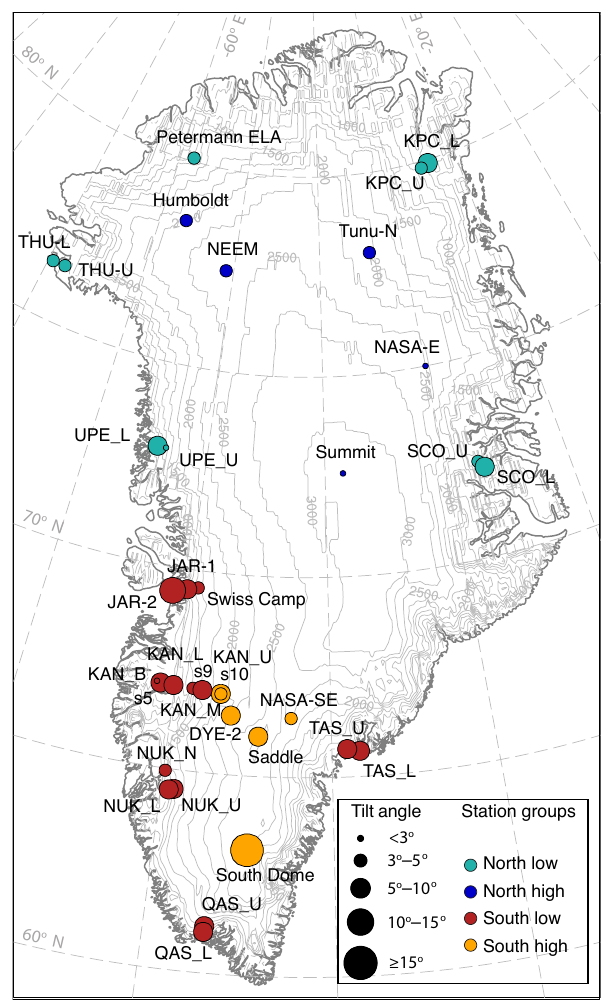
Figure 1. The automatic weather stations used in this study and their average tilt angles ( β ). Stations are separated into four groups based on their latitudes and